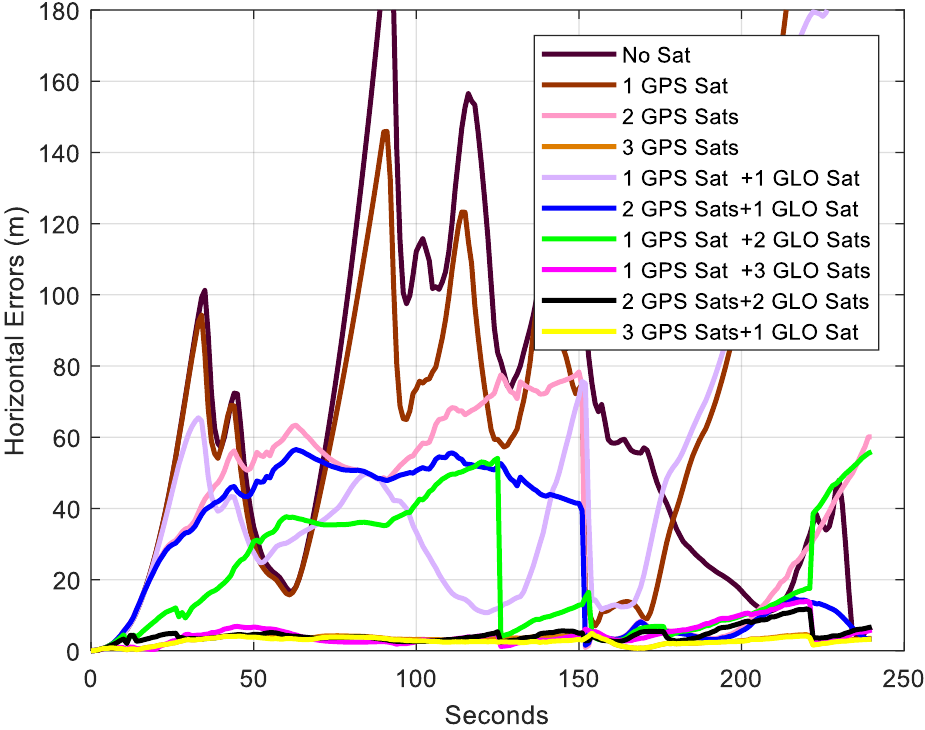
Figure 12. Horizontal errors of trajectories using different satellites.